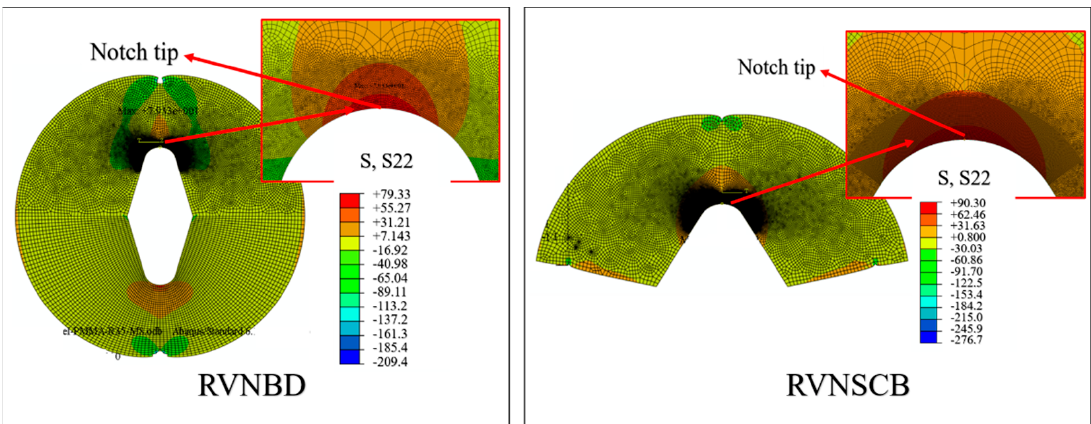
Figure A2. Typical meshing patterns for RVNBD and RVNSCB samples (R5). including RV notch.